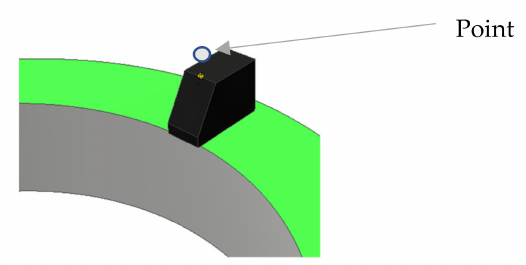
Figure 4. A point on contact element which was used for trajectory calculations.